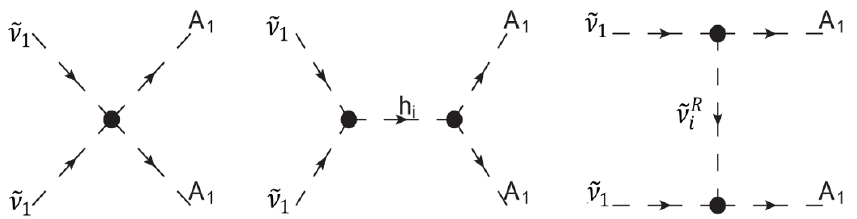
Figure 1 . Feynman diagrams for the annihilation ~ (cid:23) 1 ~ (cid:23) 1 ! A 1 A 1 . Note that there exist both t and u channel contribution to the annihilation in the right